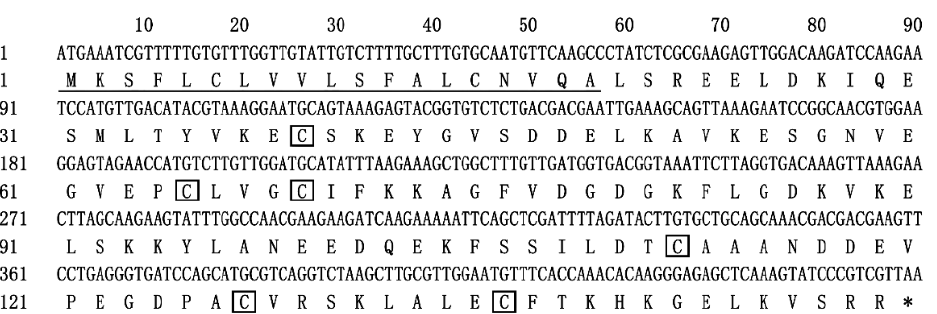
Figure 1. The cDNA and deduced amino acid sequences of TrufOBP4. The predicted signal peptide is indicated by underlining. The conserved Cys sites are indicated in black boxes. The translation- termination codon is marked by an asterisk